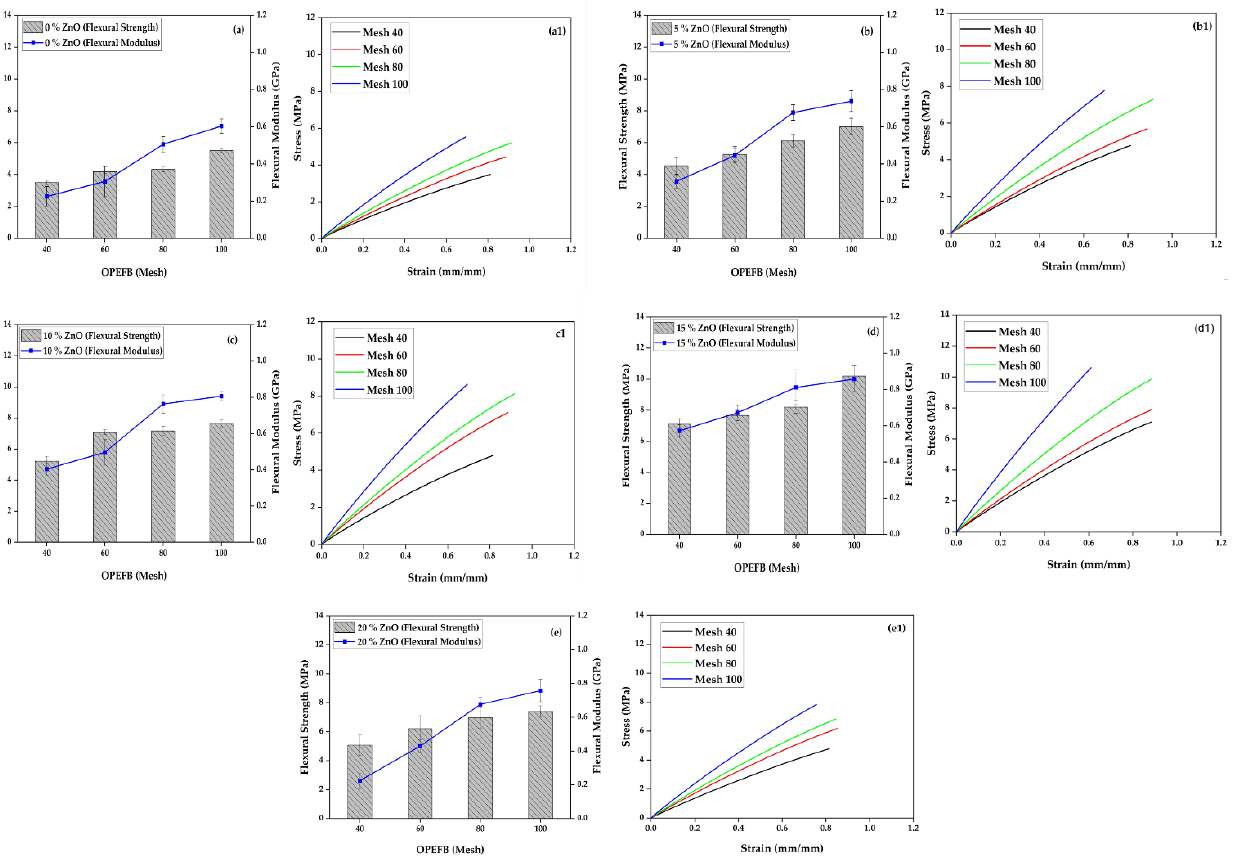
Figure 4. Flexural properties of foamed polymer composites at different OPEFB particle sizes and ZnO fillers, ( a ) 0% ZnO, ( b ) 5% ZnO, ( c ) 10% ZnO, ( d ) 15% ZnO, ( e ) 20% ZnO, ( a1 − e1 ) flexural stress–strain diagrams.